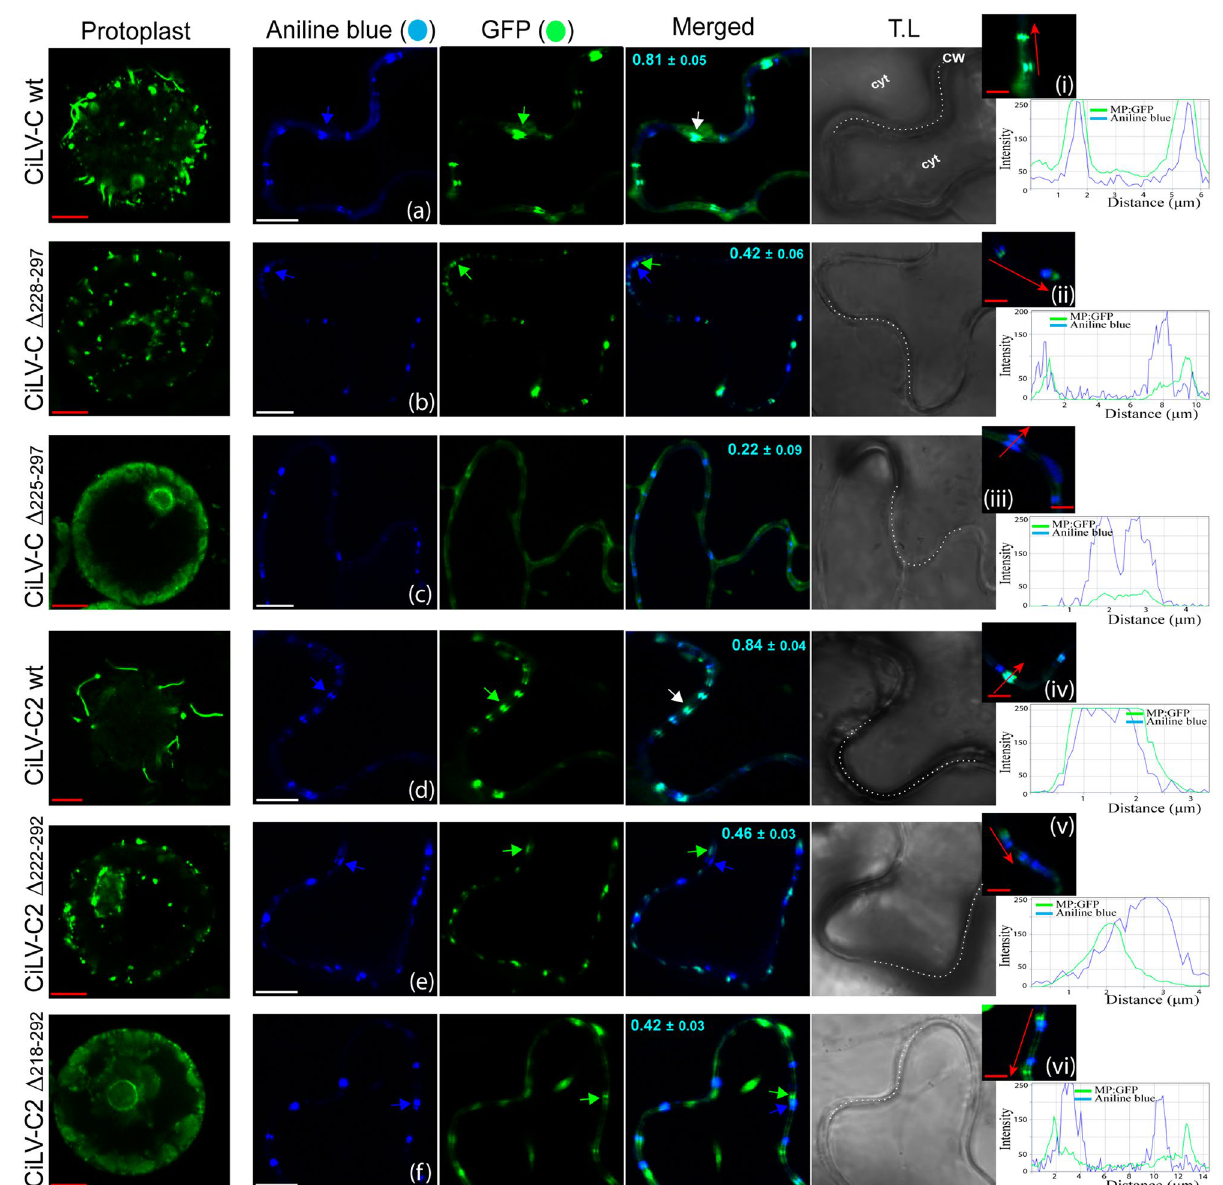
Figure 5. The C-terminal region of cileviruses MP is necessary for correct co-localization with plasmodesmata. Transient expression of CiLV-C wild type ( a ), CiLV-CΔ 228–297 ( b ), CiLV-CΔ 225–297 ( c ), CiLV-C2 wild type ( d ), CiLV-C2Δ 222–292 ( e ) and CiLV-C2Δ 218–292 ( f ) MPs, carrying the GFP (green filled circle) in N. benthamiana leaves. Fluorescence signal was captured at 72 h post-infiltration. The callose deposits were stained using aniline blue (blue filled circle). The blue and green arrows indicate the callose deposits in plasmodesma and MP, respectively; while the white arrows indicate co-localization between them. The blue (aniline blue), the green (GFP), transmitted light (TL) channels and merged images are shown in the figure. Images on the left show the tubule formation of N. benthamiana protoplast transiently expressing the correspondent MP construct. The MP punctate structures co-localize at the cell periphery with the fluorochrome for the MP wt constructs ( a,d ), while the truncated MP constructs show no co-localization or partial co-localization ( b,c,e,f ). In a higher magnification image, it is shown the complete (i,iv) or partial (ii,iii,v,vi) co-localization of the MP with callose deposits in the plasmodesmata, and the chart of fluorescence intensities further confirms the co-localization. Plot shows green and blue fluorescence intensities, indicated by MP:GFP and aniline blue, in the selected region of interest (red arrows). Distance measurement starts from the base to the tip of the arrows (x axis). The mean SD of Person Correlation Coefficient (PCC) is given in the merged image. PCC was measured using the Fiji co-localization plugin for three independent images from approximately 100 individual plasmodesmata. The dotted line in the transmitted light image indicates the cell wall (CW). Cyt cytoplasm. Red and white bars correspond to 5–10 and 20 μm,